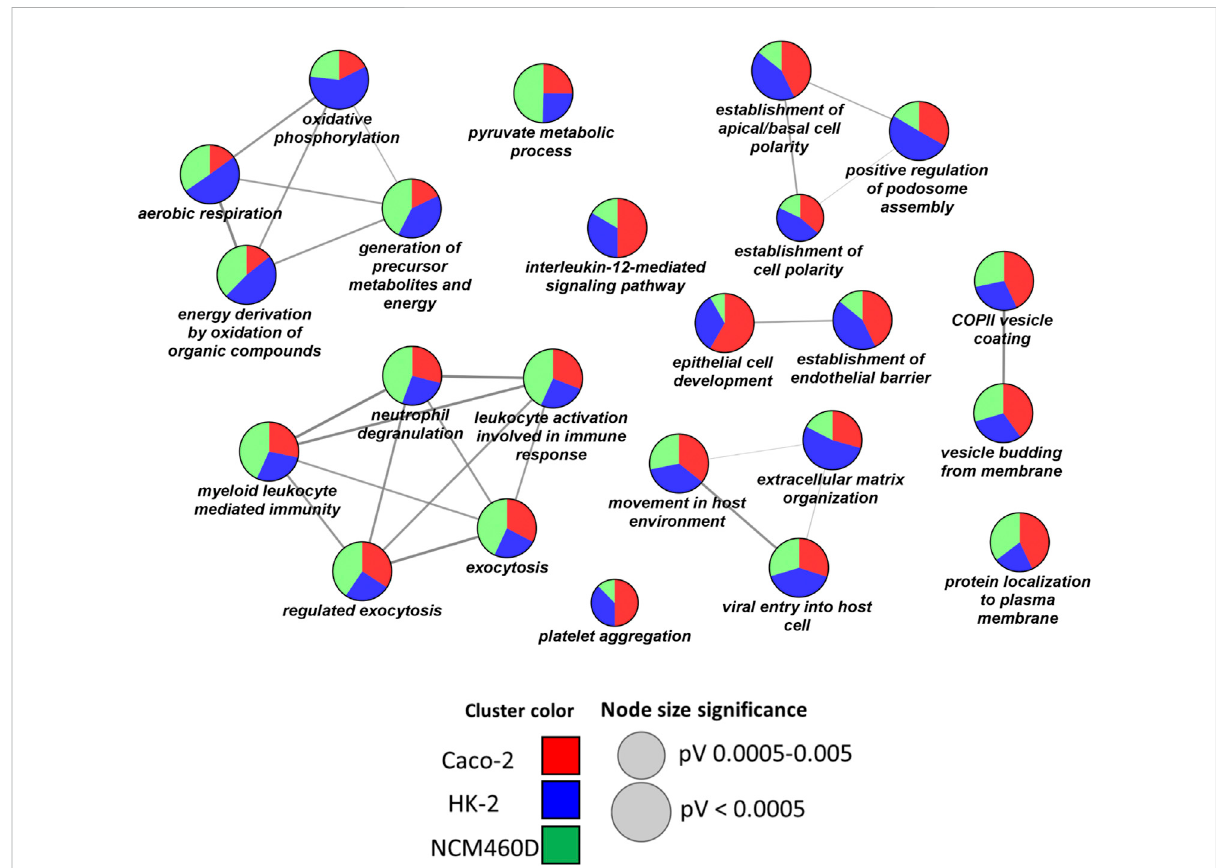
FIGURE 4 Biologicalprocesses enrichmentanalysisbyClueGO.Networkrepresentationoftheenrichedprocesses ineachcellline.Thetermsenrichedin HK-2, NCM460D, and Caco-2 are represented as blue, green, and red pie slices, respectively. The slice extent represents the contribution of the speci fi c dataset to the term. The node sizes are proportional to the FDR